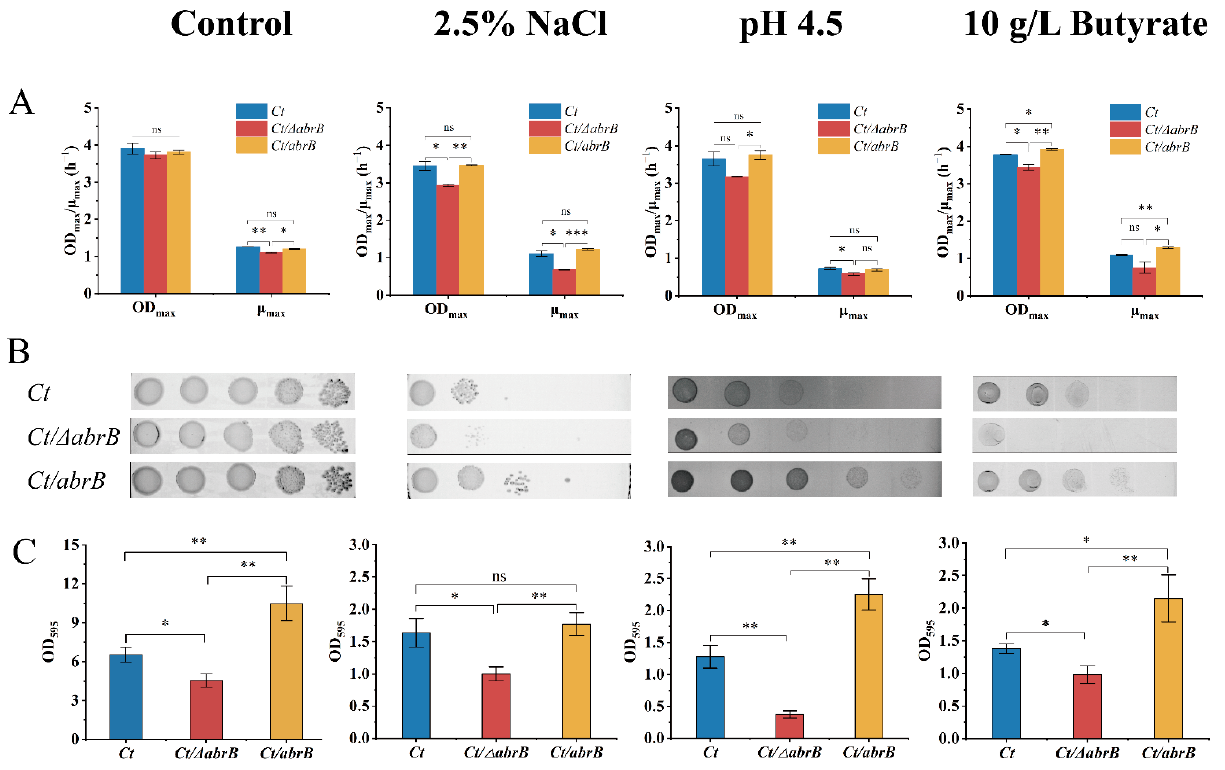
Figure 5. Deletion of abrB impairs the tolerance of C. tyrobutyricum to adverse environments. ( A ) The growth condition of Ct , Ct/ Δ abrB and Ct/abrB under different adverse environments; ( B ) Spot assays of Ct , Ct/ Δ abrB and Ct/abrB ; ( C ) Adhered biofilm formation of Ct , Ct/ Δ abrB and Ct/abrB. (ns, non-significant; *, p < 0.05; **, p < 0.01, one-way ANOVA). The data are the means and standard deviations of three replicates.